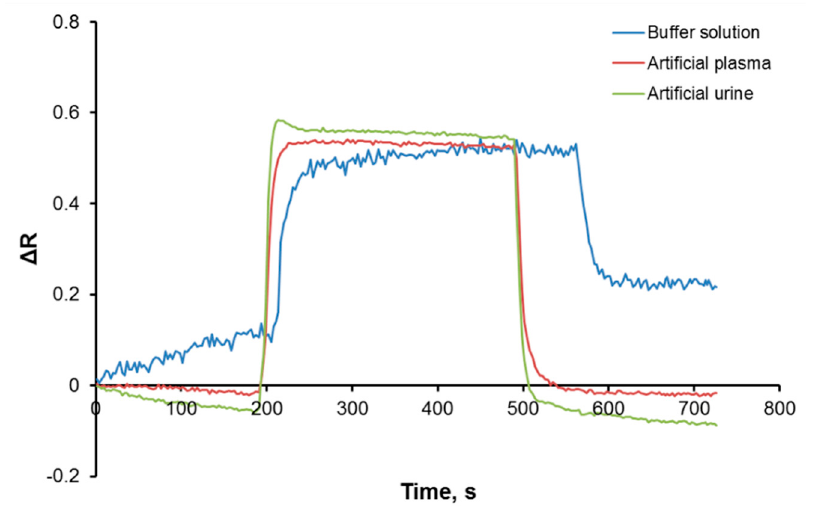
Figure 7. Real-time Cu(II) detection with Cu(II)-imprinted plasmonic sensor in complex media.